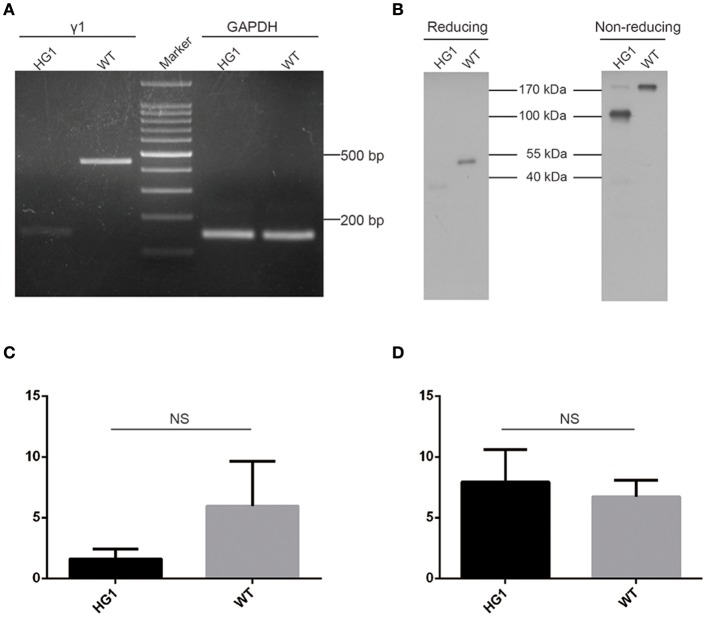
Characterization of γ1 gene expression in HG1 mice. (A) PCR detection of the γ1 transcript in HG1 mice. (B) Western blotting showing IgG1 levels in the serum of HG1 mice. (C) qRT-PCR analysis of the transcription of the γ1 gene in HG1 mice. (D) qRT-PCR analysis of the transcription of the μ gene in HG1 mice.